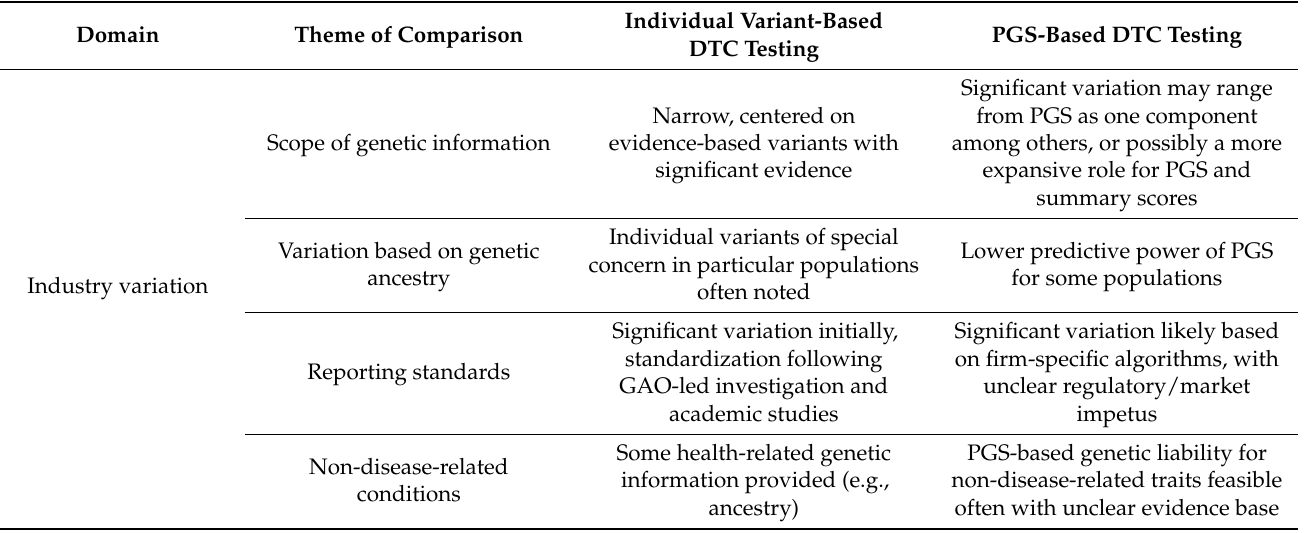
Table 1. Comparison Between Two Types of